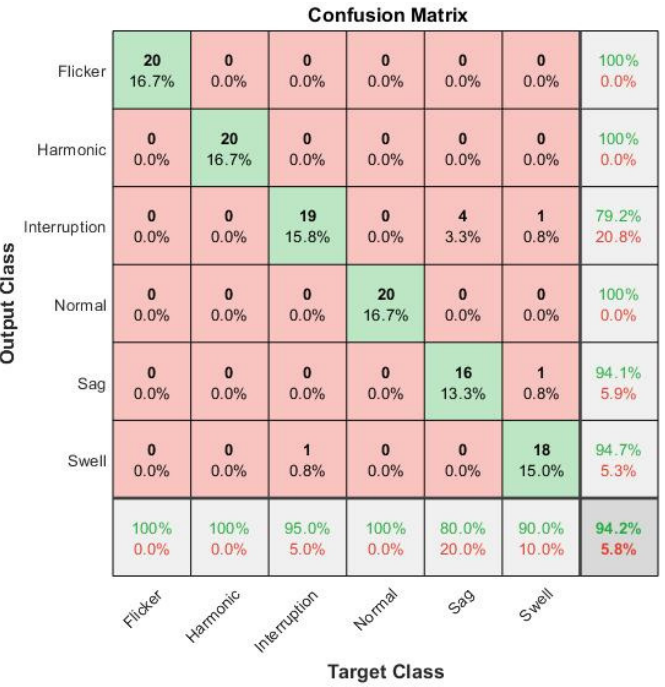
Figure 9. CNN resulting image .